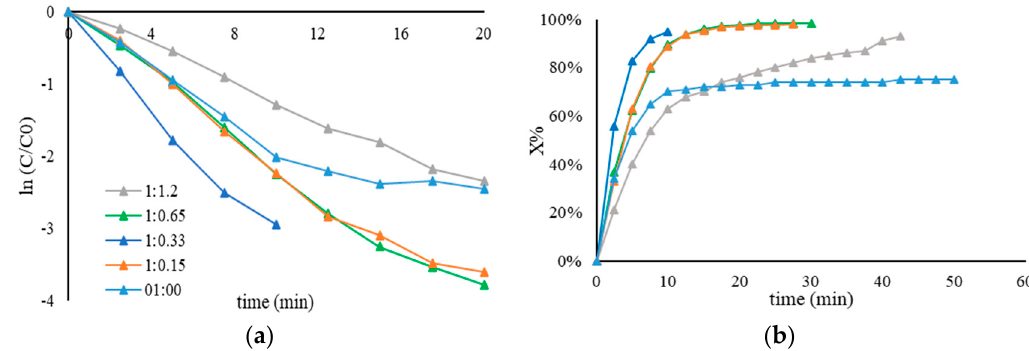
Figure 6. ( a ) Pseudo–first − order kinetic plot and ( b ) conversion plot using Au/AC synthesized using PVA-60 (derived from a PVAc Mn = 23,300) by varying the Au/PVA weight ratio. Reaction carried out by using 25 mL of 4–NP (2 × 10 − 4 M) and 25 mL of NaBH 4 (9 × 10 − 3 M), 25 °C and different PVA amounts: 1.2 mL (Au/PVA ( w / w )= 1:1.2), 0.65 mL (Au/PVA ( w / w )= 1:0.65), 0.33 mL (Au/PVA ( w / w )= 1:0.33), 0.15 mL (Au/PVA ( w / w )= 1:0.15), and 0 mL (Au/PVA ( w / w )= 1:0). Table 11. Values of the apparent constant and conversion for pseudo-first-order reactions using PVA-60 (derived from a PVac Mn = 23,300), by varying the Au/PVA weight ratio.